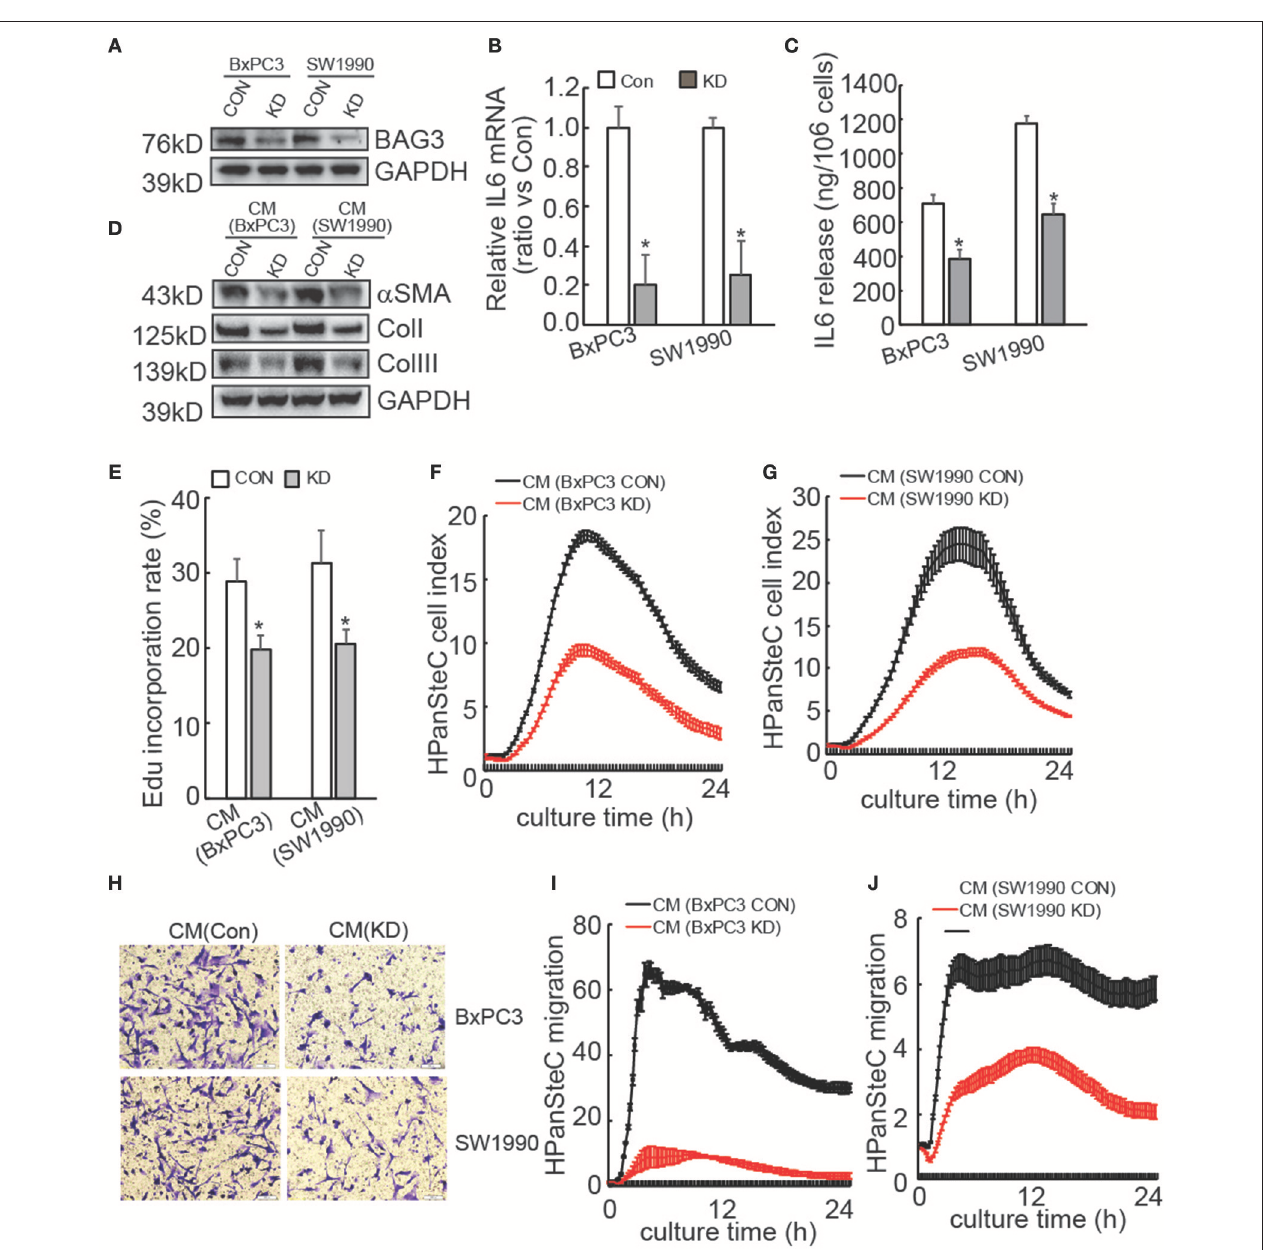
FIGURE 1 | Activation of PSCs is compromised by supernatants of PDACs with BAG3 knockdown. (A) BxPC3 or SW1990 cells were infected with control (CON) or gRNA guided BAG3 (KD) using CRISPR/Cas9 system, BAG3 expression was confirmed using Western blot. (B) IL6 mRNA expression was analyzed in the indicated cells using real-time PCR. (C) IL6 extracellular release was analyzed in the indicated cells using ELISA and standardized the control and the experimental group by cell numbers. (D–J) HPanSteC cells were incubated with conditional medium (CM) collected from BxPC3 or SW1990, α SMA, and collagen expression was analyzed using Western blot analysis (D) , DNA synthesis was analyzed using Edu incorporation (E) , cell proliferation was analyzed using RTCA (F,G) , cell migration was analyzed using Transwell (H) , and RTCA (I,J) , respectively. * P <